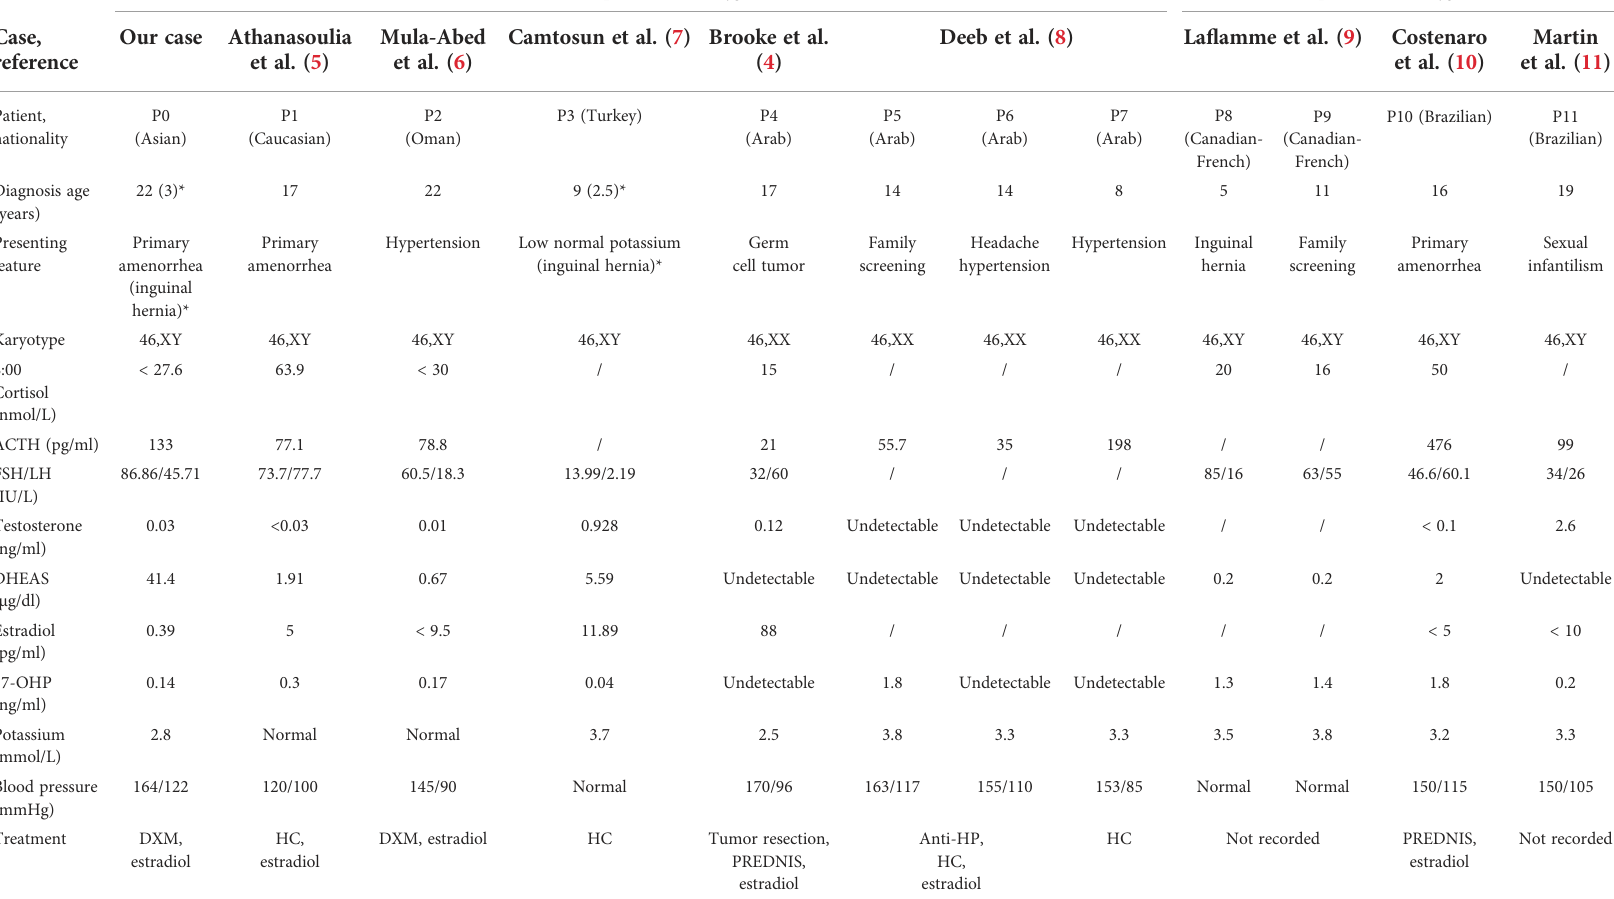
TABLE 2 Clinical characteristics of patients with R96W or R96Q